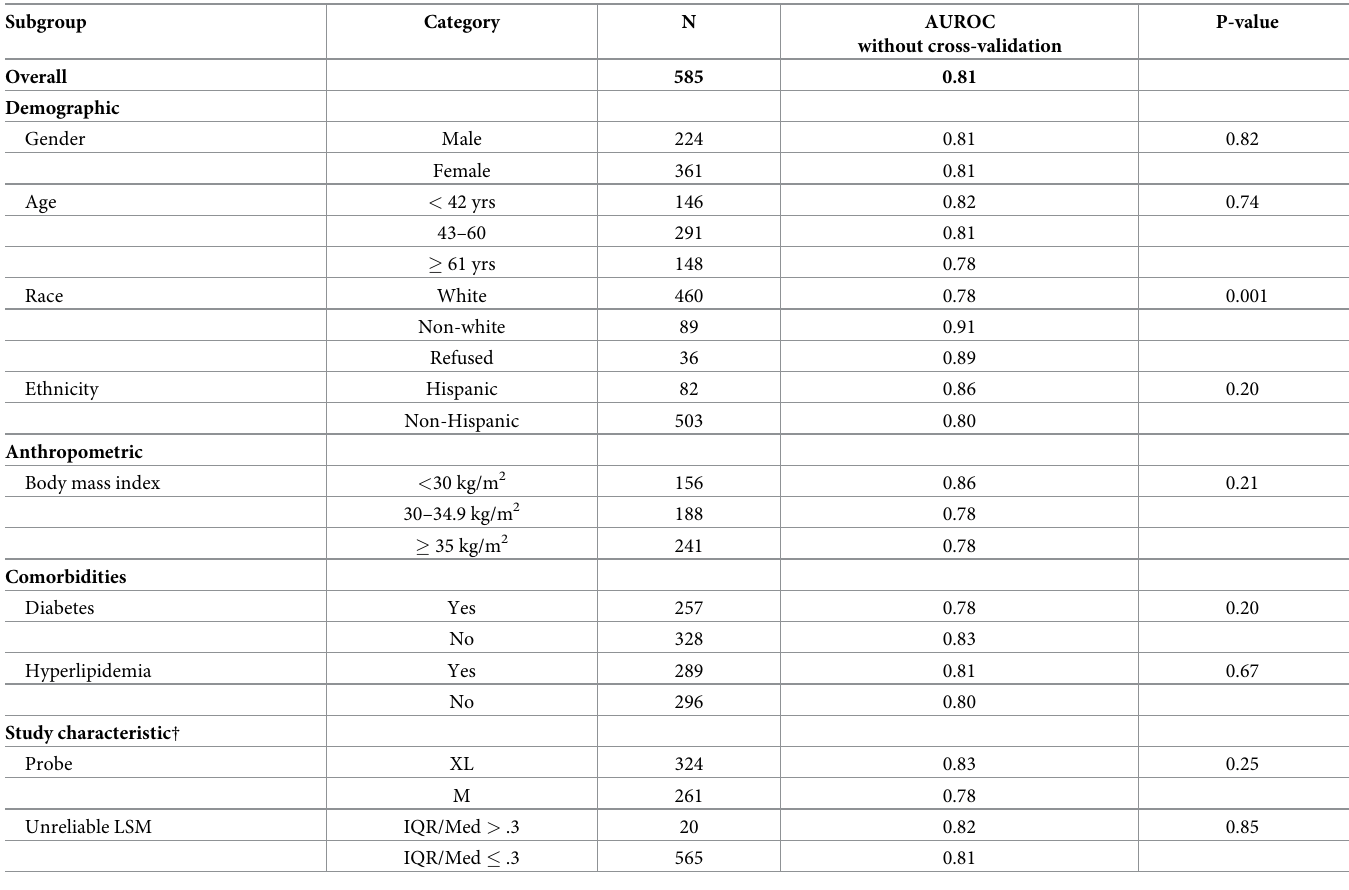
Table 4. Comparison of diagnostic accuracy of FAST ™ for at-risk NASH by